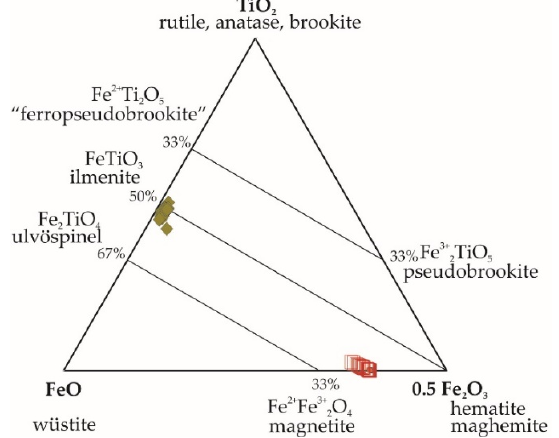
Figure 8. The composition of Fe-Ti oxides plotted in a TiO 2 -FeO-0.5Fe 2 O 3 ternary diagram in ore samples from the Krzemianka and Udryn Fe-Ti-V deposits in NE Poland. Explanation of calculation (in atomic proportions): TiO 2 –Ti (IV); FeO = Fe (II) + Mg (II) + Mn (II) + 2O (II); Fe 2 O 3 = Fe (III) + Cr (III) + Al (III) + V (III) + 3O (II).